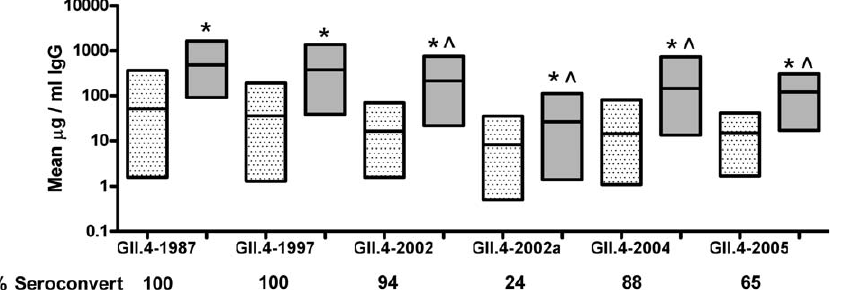
Figure 8. Anti-GII.4 VLP IgG Titers The geometric mean titer of anti-VLP IgG ( l g/ml) for acute (dotted bars) and convalescent (shaded bars) serum samples collected from a 1988 GII.4 outbreak and the percentage of individuals who seroconverted to each VLP. The mean titer is indicated by the line in the box. The upper and lower boundaries of the box represent the maximum and minimum values. *Significant increase in titer between acute and convalescent samples ( p , 0.05, M-W). ^ Significant difference between convalescent titers compared to GII.4–1987 ( p , 0.05, M-W).